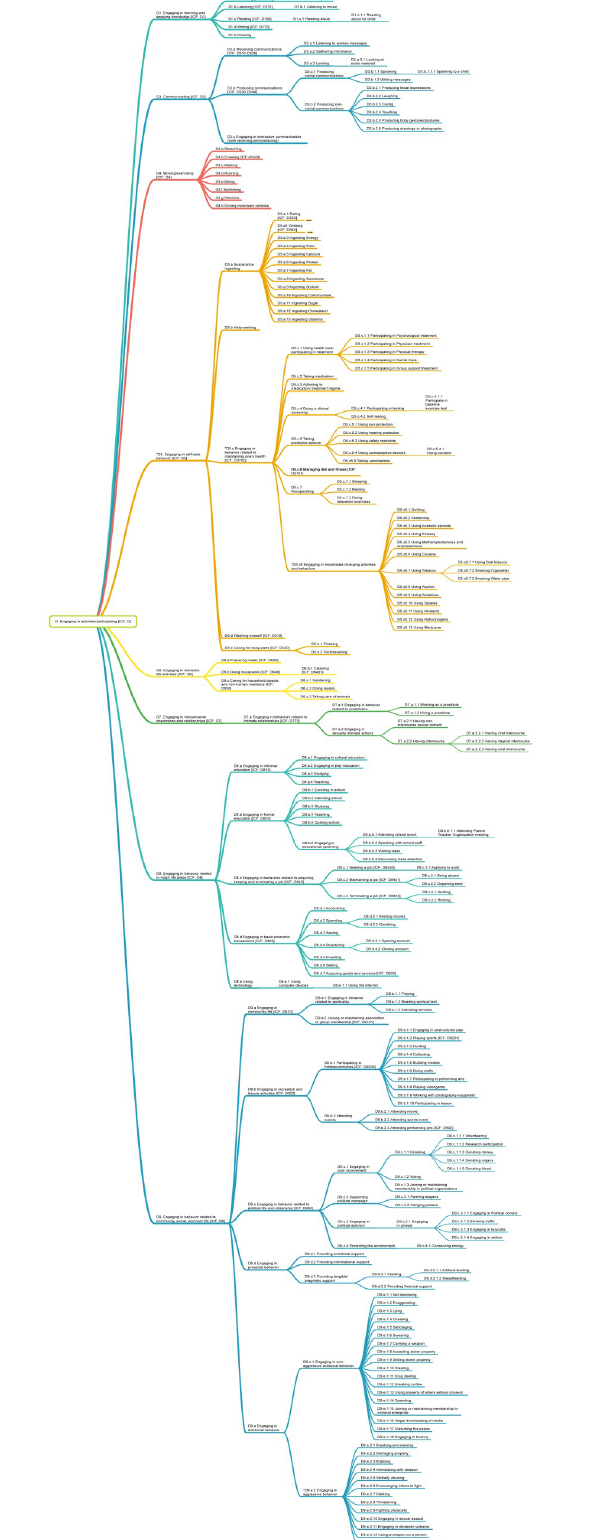
Fig 3. IC-Behavior